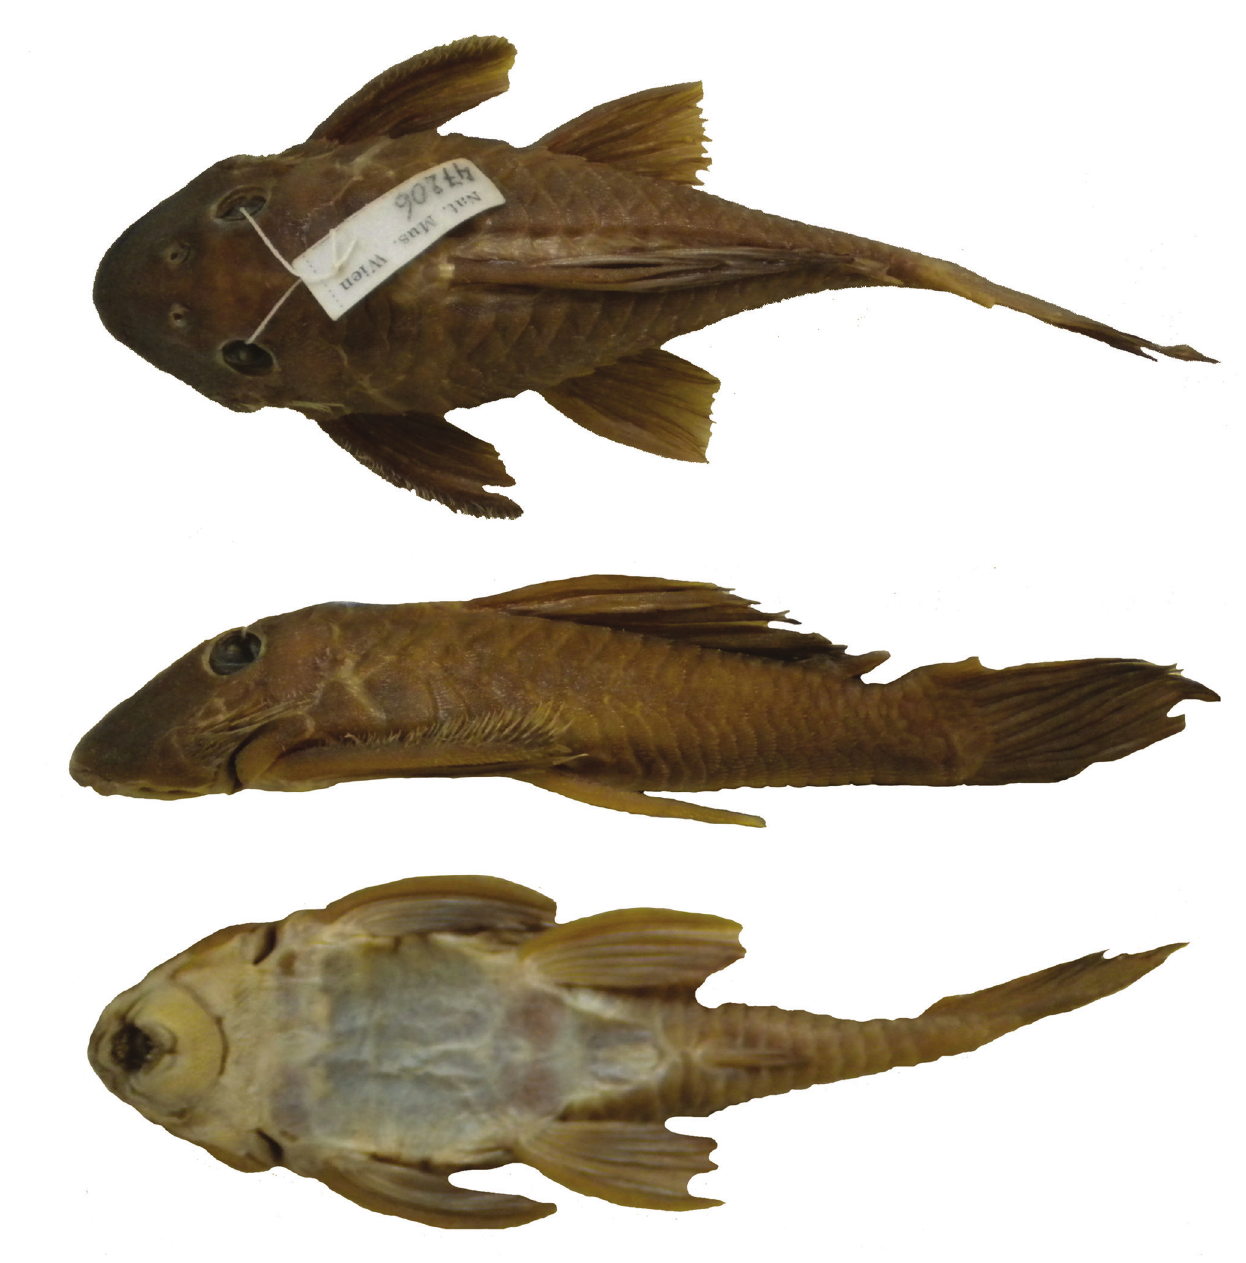
Fig. 6. Spectracanthicus punctatissimus , holotype, NMW 47206, 104.0 mm SL, rio Xingu, Pará State,